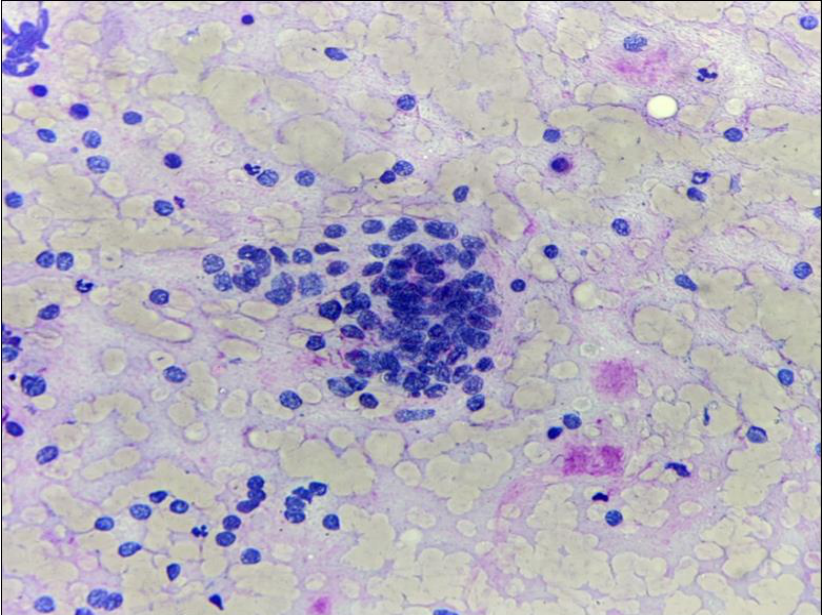
Fig. 4. Adenoid Cystic Carcinoma cytology showing a cluster of cells with round monomorphic nuclei, granular chromatin, and inconspicuous nucleoli. (H&E,400X). Thirty-eight cases were available for the histopathological examination, out of which 34 cases showed a positive correlation (Table